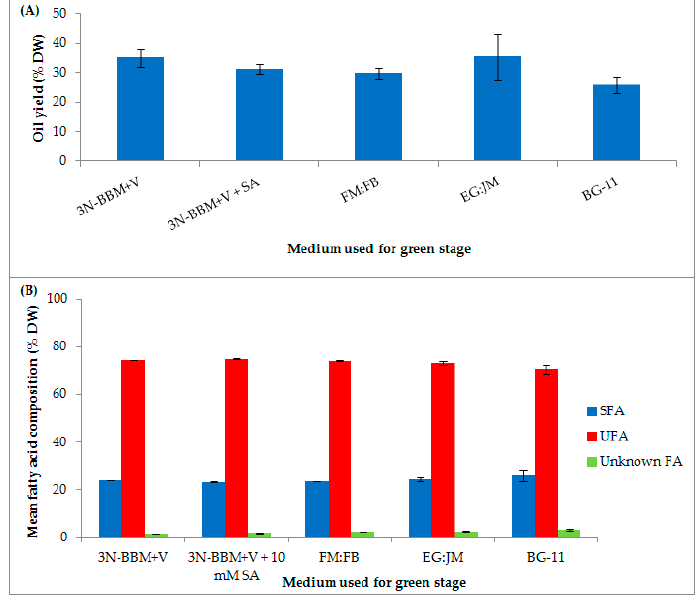
Figure 9. H. pluvialis cultivated in a range of media under autotropic and mixotrophic conditions ( A ) Mean total fatty acid content (% DW); ( B ) mean fatty acid composition (% DW) as saturated, unsaturated or unknown fatty acids. Mean DW (g·L − 1 ) ± S.D. ( n = 3). Cultures incubated for 10 days in the green stage in various autotrophic and mixotrophic media and 12 days in the red stage in medium without nitrate (20 °C, continuous light at 240 µmol photons m − 2 ·s − 1 ). SFA = Saturated fatty acid, UFA = Unsaturated fatty acid, Unknown FA = Unknown fatty acid.